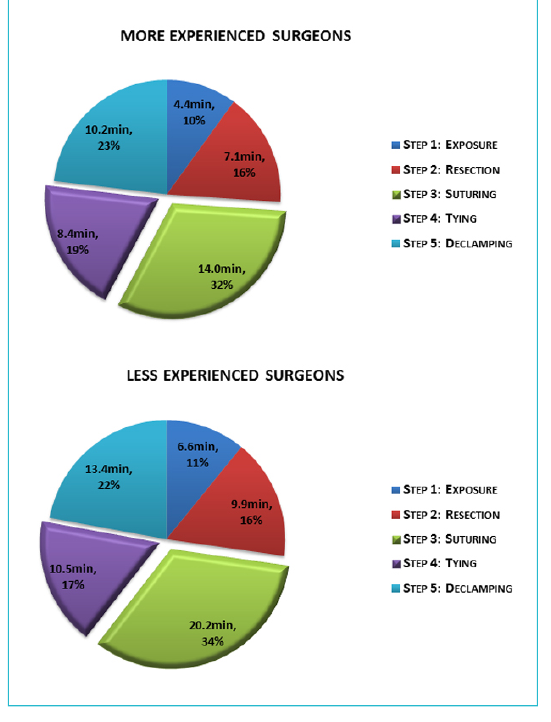
Figure 4: Comparison between less and more experienced sur- geons in distribution of the five steps of aortic cross-clamp